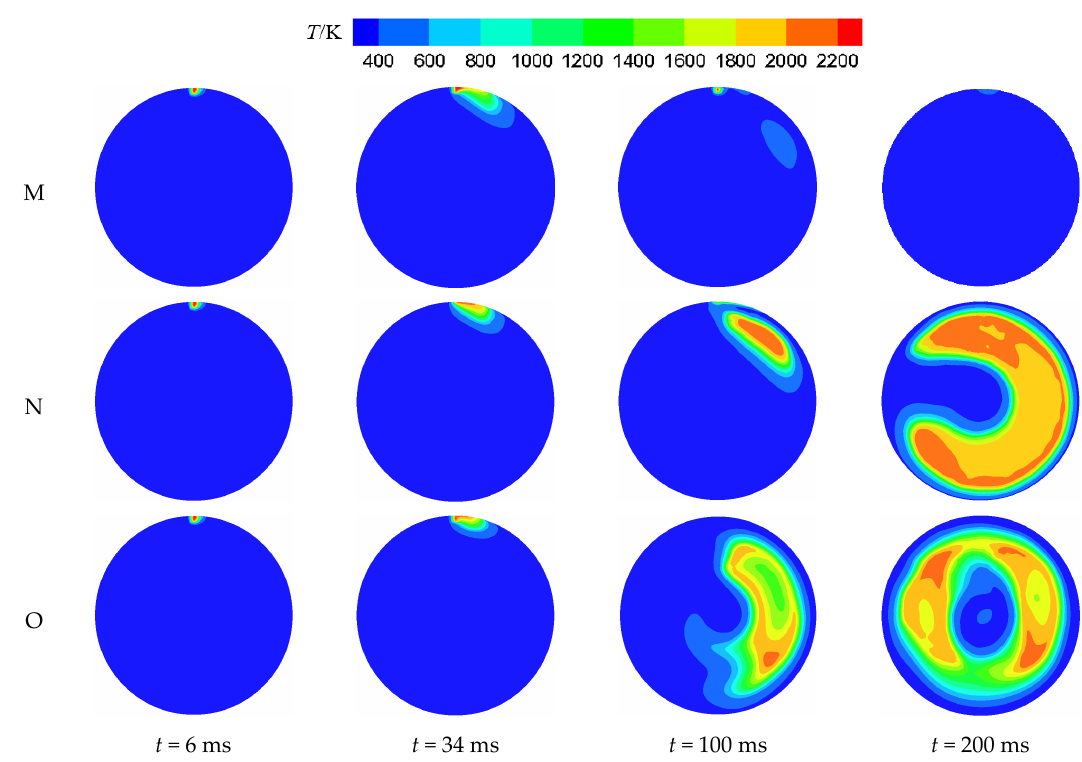
Figure 15. Numerical temperature field of combustor cross section (X = 130 mm) in Cases M–O.